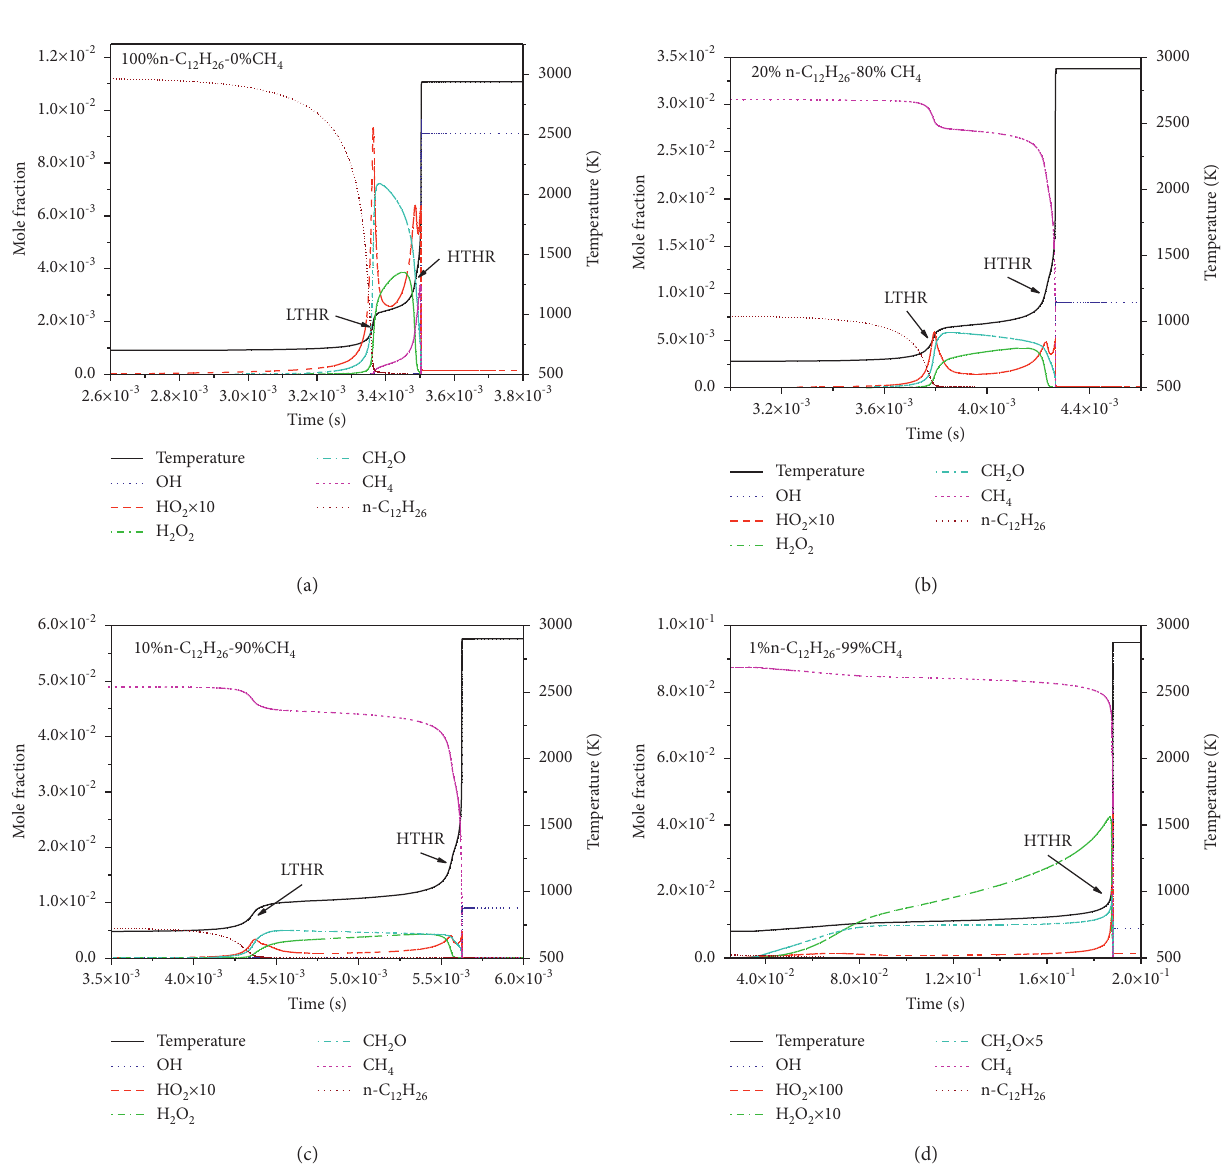
� 1.0, P � 20bar, and T � total